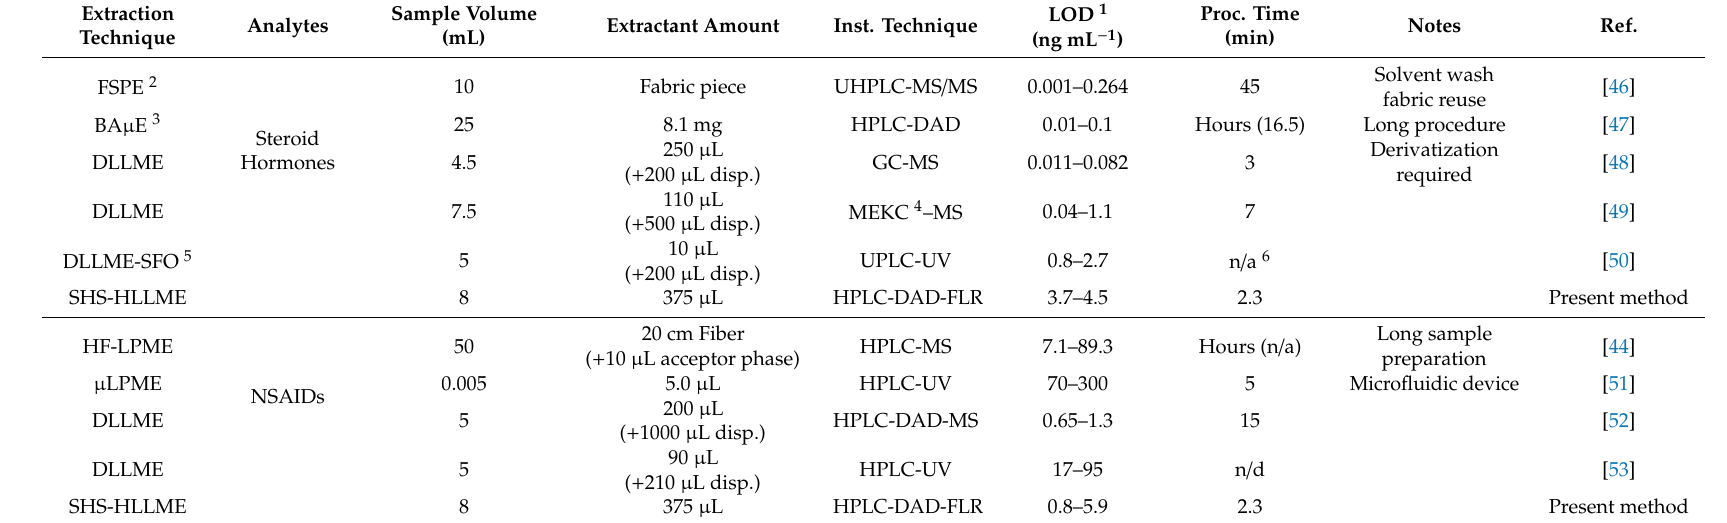
Table 3. Comparison of the proposed extraction procedure with other published methods for the pharmaceutical compounds from water